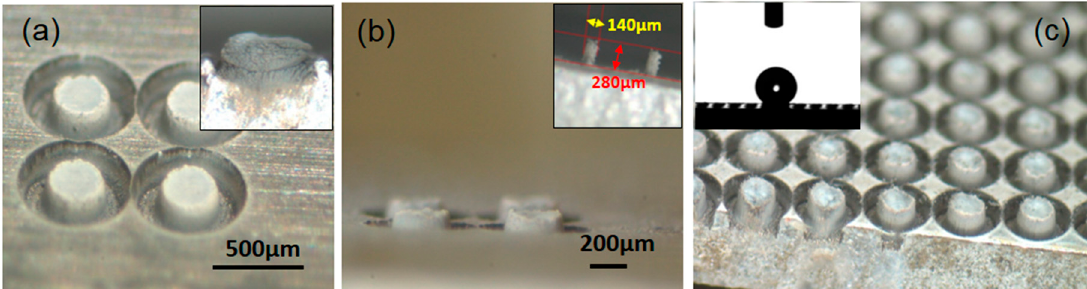
Figure 4. ( a ) Four sub-mm sized pillars made by the ultrafast laser additive surface structuring (LASS) process, plus ultrafast laser substractive ablation at the contour of the pillar blocks to sharpen the edges. The inset shows a single AS unit without its edge being sharpened; ( b ) Tilted view of the pillars. The pillars can be grown higher, at the cost of pillar diameter, as shown in the inset; ( c ) Pillars similar to those in ( a ) are fabricated on a large scale for achieving a superhydrophobicity at the surface, as demonstrated in the inset.